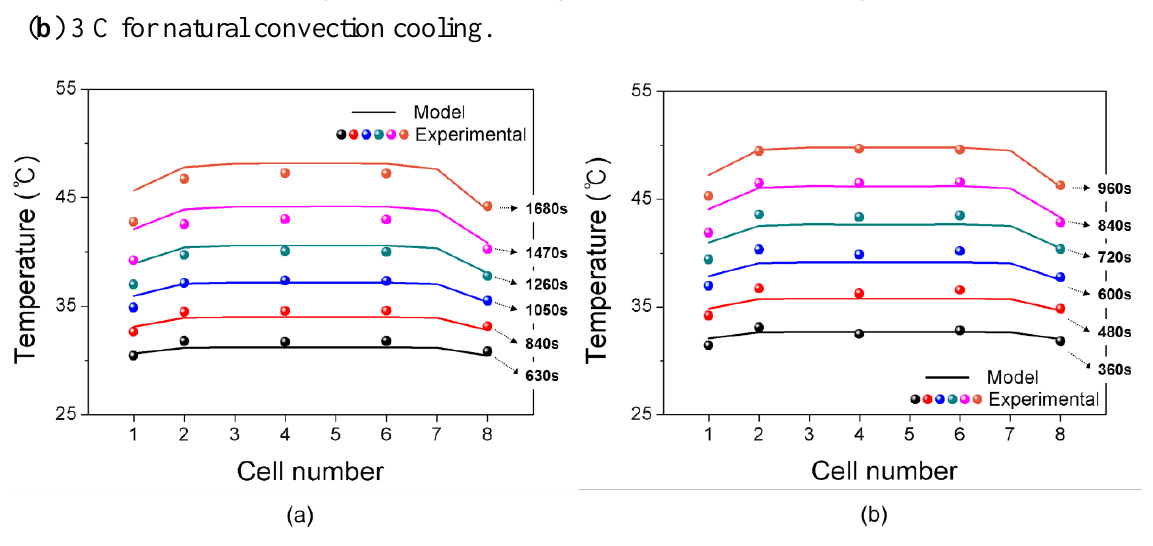
Figure 7. Temperature distributions of the LIB cells within the module at a few cross sections along the y direction at the discharge time of 1680 s with the discharge rate of 2 C for natural convection